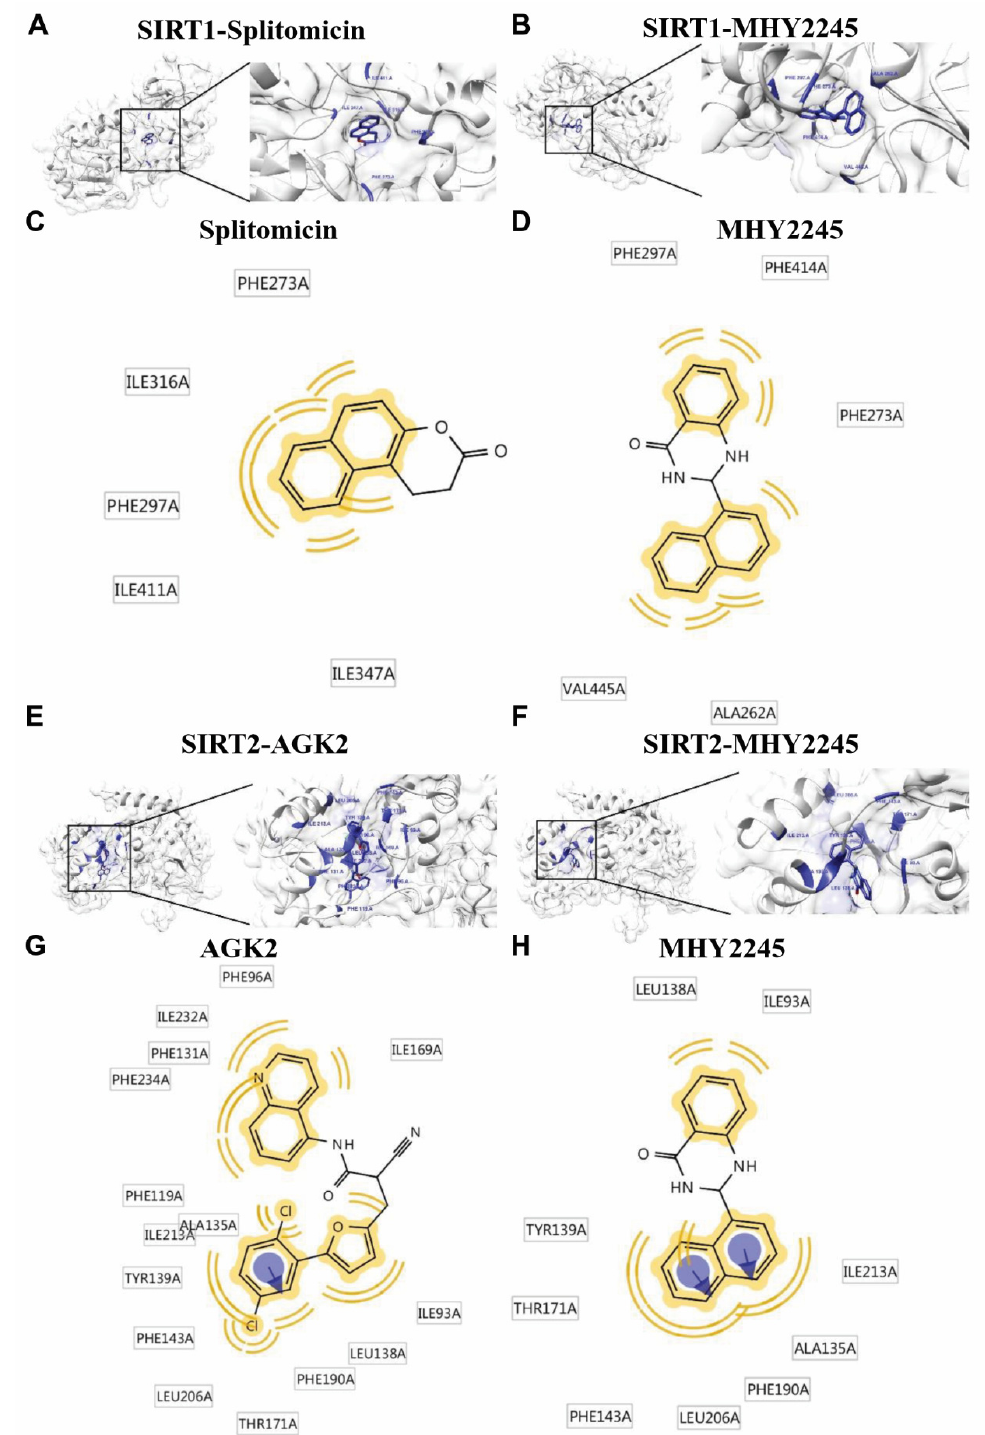
Figure 3. Docking simulation of MHY2245, splitomicin, AGK2 with SIRT1/2, and pharmacophore analysis. Docking simulation results between splitomicin ( A ) and MHY2245 ( B ) toward human SIRT1. Pharmacophore results for splitomicin ( C ) and MHY2245 ( D ) obtained using LigandScout 4.1.5 showing hydrophobic (yellow) interactions. Docking simulation results between AGK2 ( E ) and MHY2245 ( F ) toward human SIRT2. Pharmacophore results for AGK2 ( G ) and MHY2245 ( H ) obtained using LigandScout 4.1.5 showing hydrophobic (yellow) interactions and aromatic interactions (violet arrow).